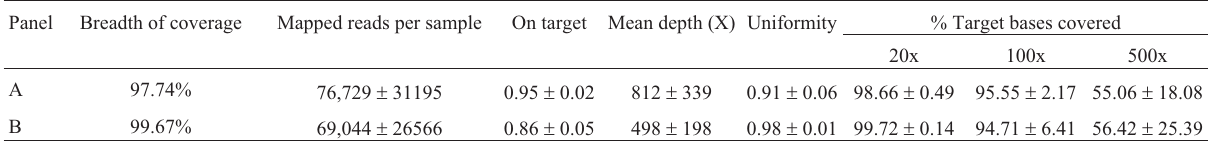
Table 1 - Performance characteristic for both LSDs panels